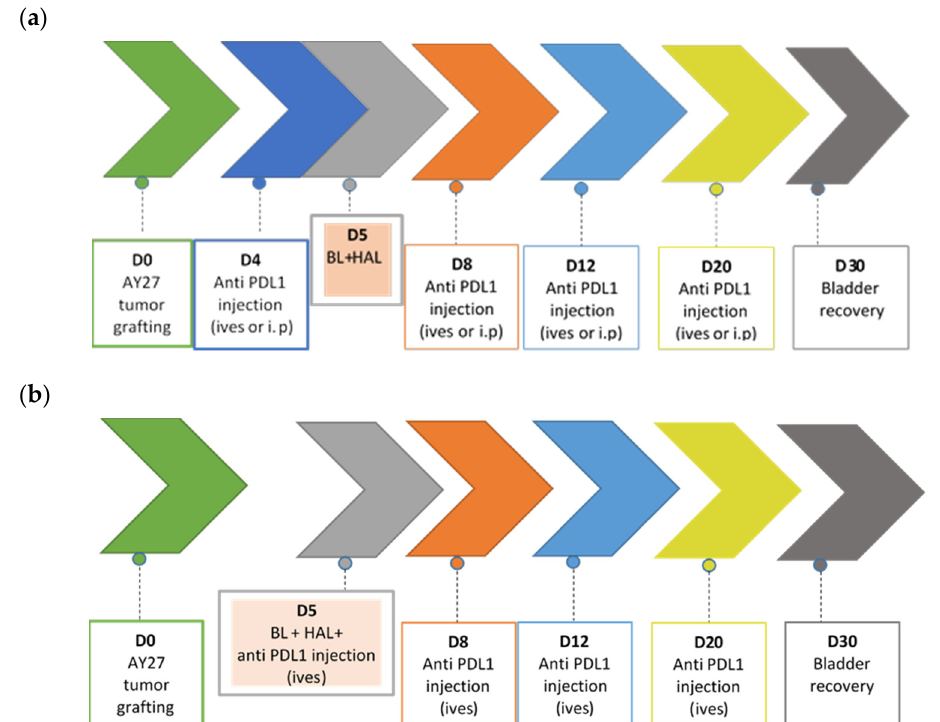
Figure 1. Experimental scheme of HAL BL treatment alone and in combination with anti PD-L1 injections. ( a ) Intraperitoneal (i.p.) and intravesical (ives) administrations; ( b ) anti PD-L1 co-administration with HAL (same syringe).